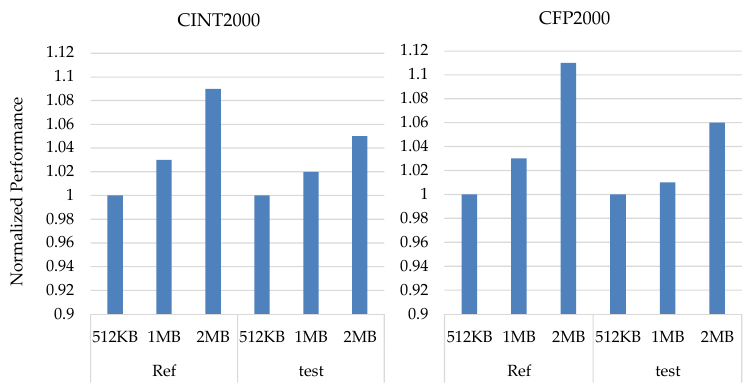
Figure 7. Performance evaluation results with ref and test input